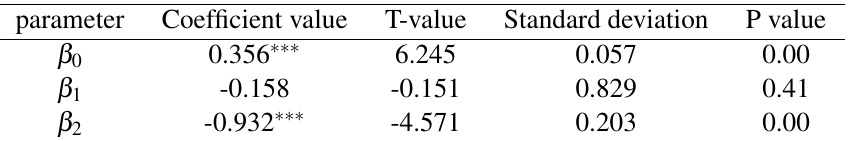
Table 1 Estimated Results of Equation (8)